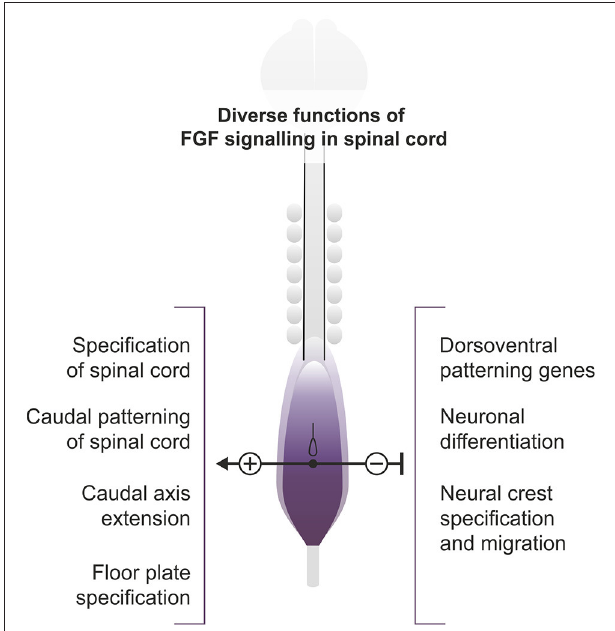
FIGURE 1 | Roles of FGF signaling in the extending spinal cord. Diagram representing a 7-somite stage chick embryo and showing the region of active caudal FGF signaling. The different processes discussed in the review either promoted ( + ) or inhibited ( − ) by FGF signaling are